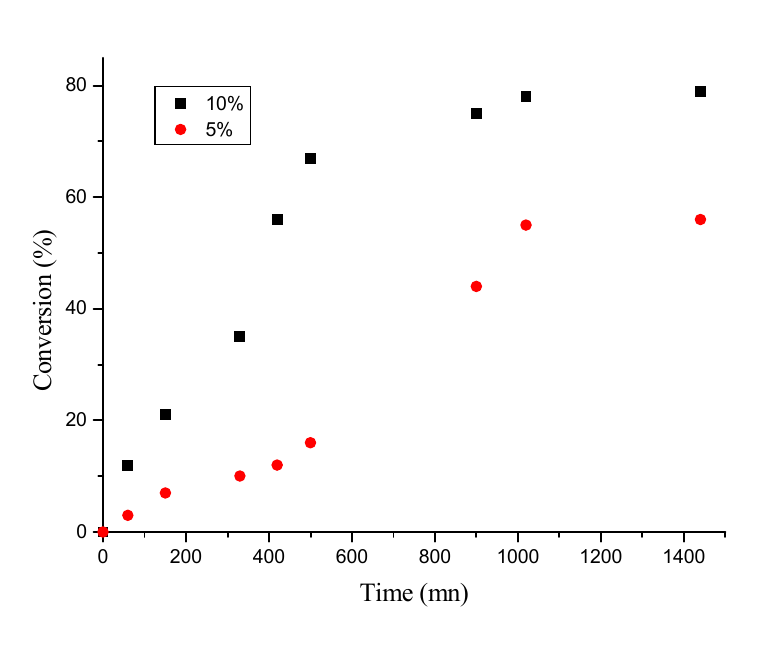
Figure 5. Effect of catalyst proportion on the conversion of